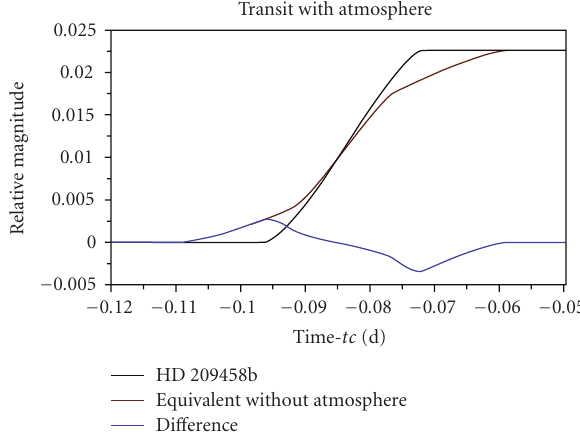
Figure 4: Theoretical e ff ect of the presence of an atmosphere in the light curve of an exoplanet transit. The transit was used for HD 209458b, with the slope equivalent to a planet with no atmosphere and the di ff erence between both.